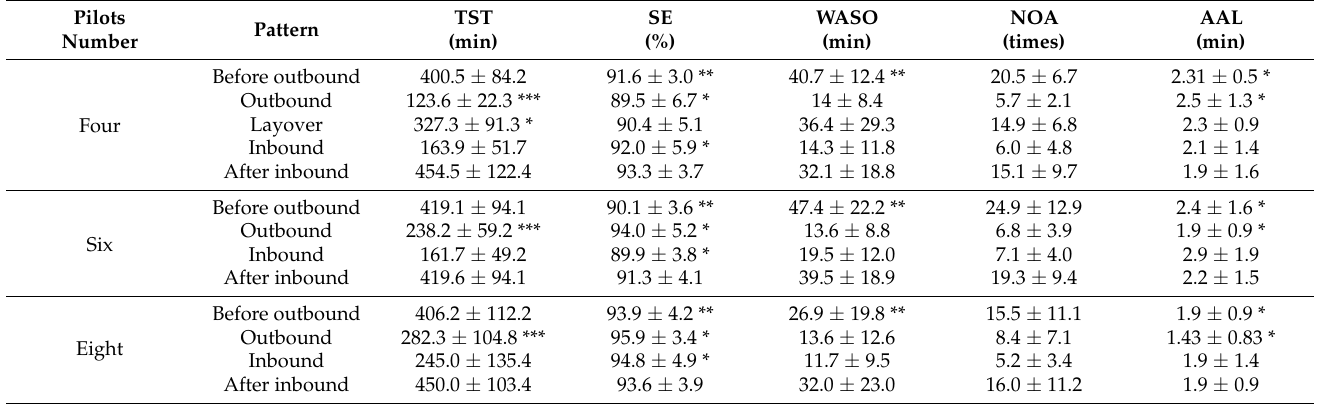
Table 2. Sleep quality in different crew